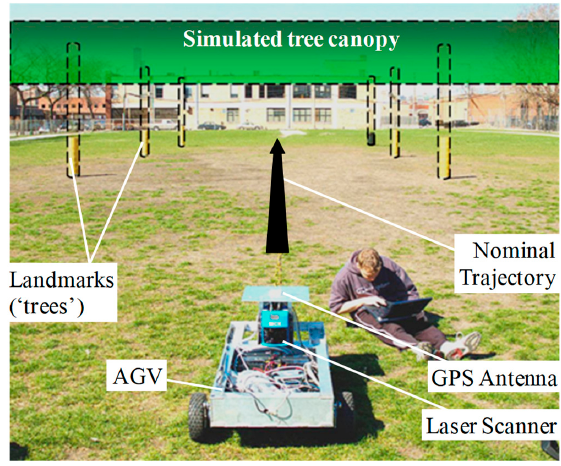
Figure 5. Experimental setup of a forest-type scenario, where a GPS/LiDAR-equipped rover is driving by six landmarks (cardboard columns) in a GPS-denied area. GPS is artificially blocked by a simulated tree canopy and a precise differential GPS solution is used for truth trajectory determination.